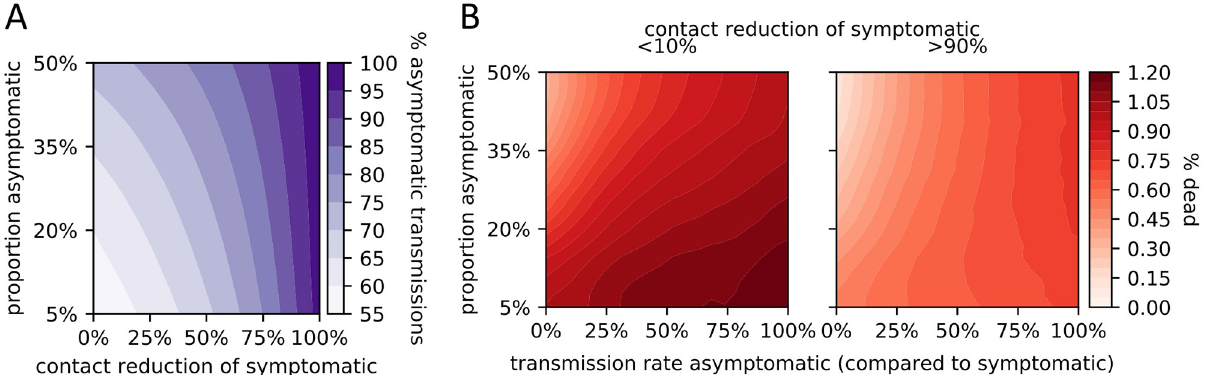
Fig 3. Impact of asymptomatic cases. (A) Effect of the proportion of asymptomatic cases (y-axis) and the contact reduction by symptomatic cases (x- axis) on the percentage of infections caused by asymptomatic cases. (B) Effect of two unknowns on the proportion dead: the proportion of asymptomatic cases (y-axis), and their relative transmission rate (compared to that of symptomatic; x-axis). Two scenarios are considered: low ( < 10%; left panel) and high ( > 90%; right panel) contact reduction by symptomatic individuals.